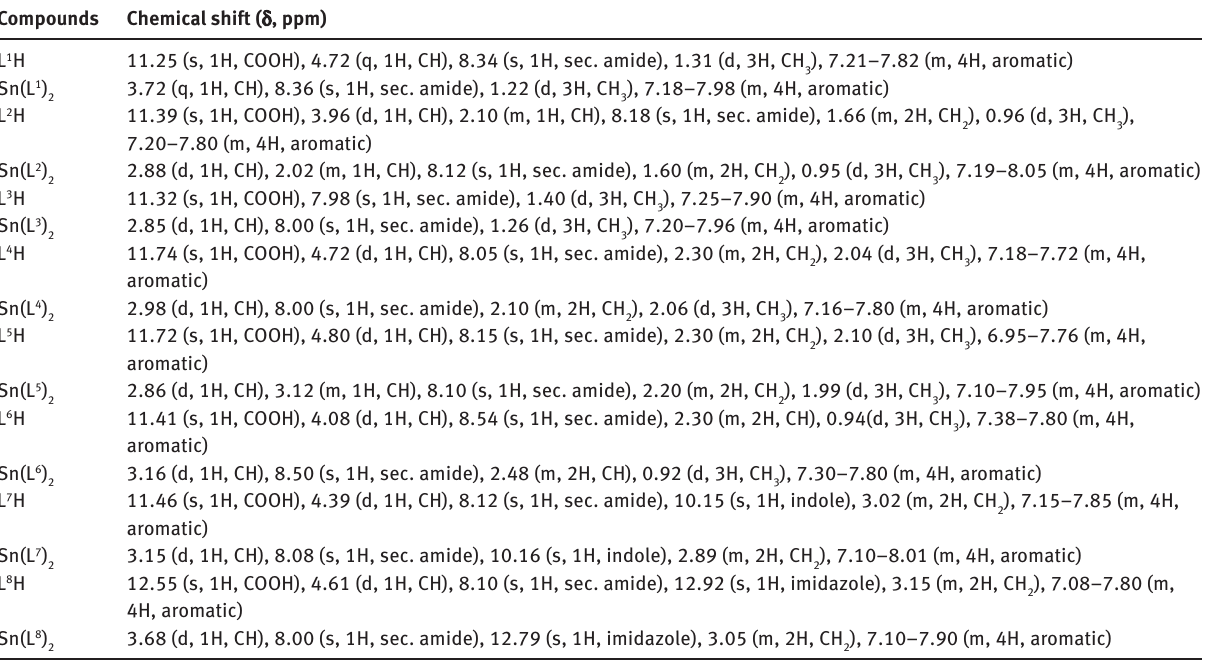
Table 3: 1 H NMR spectral data a of the ligands and their corresponding tin(II) complexes. Compounds Chemical shift ( δ ,